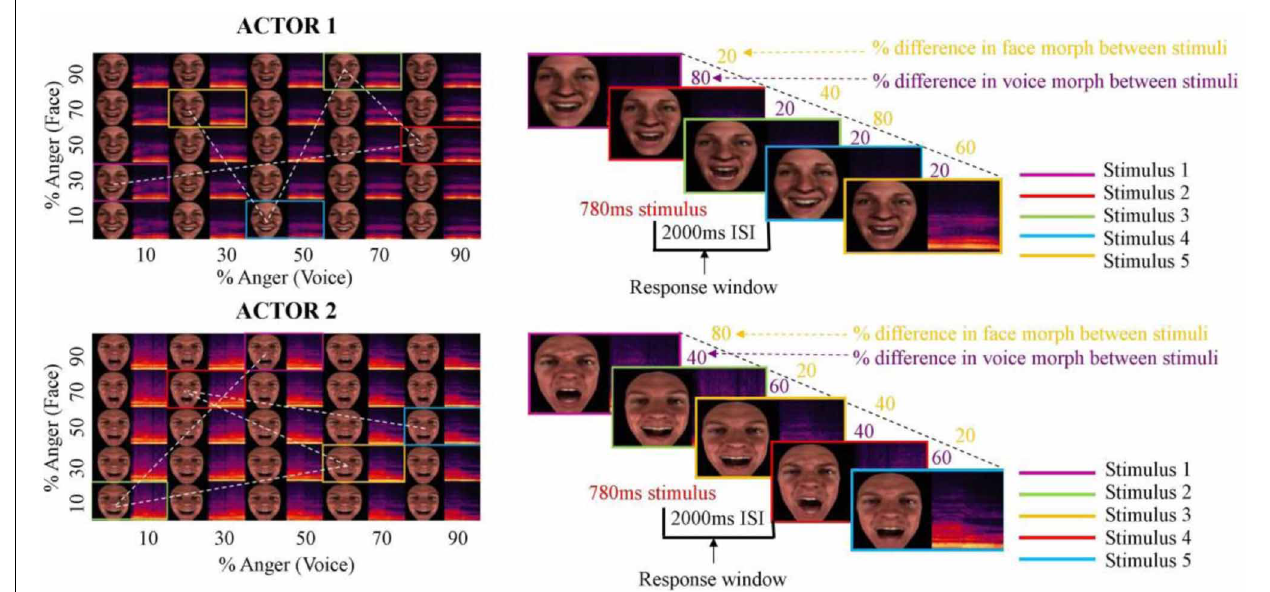
FIGURE 1 | Stimuli and continuous carry-over design. Anger and happiness expressions produced by two actors were morphed in both face and voice between 10and 90% anger, in 20% steps. These were then paired in all possible combinations, creating 25 different audiovisual stimuli per actor. Left hand panels show face morphs and voice morphs, and resultant audiovisual pairings (examples in colored rectangles). Expressions